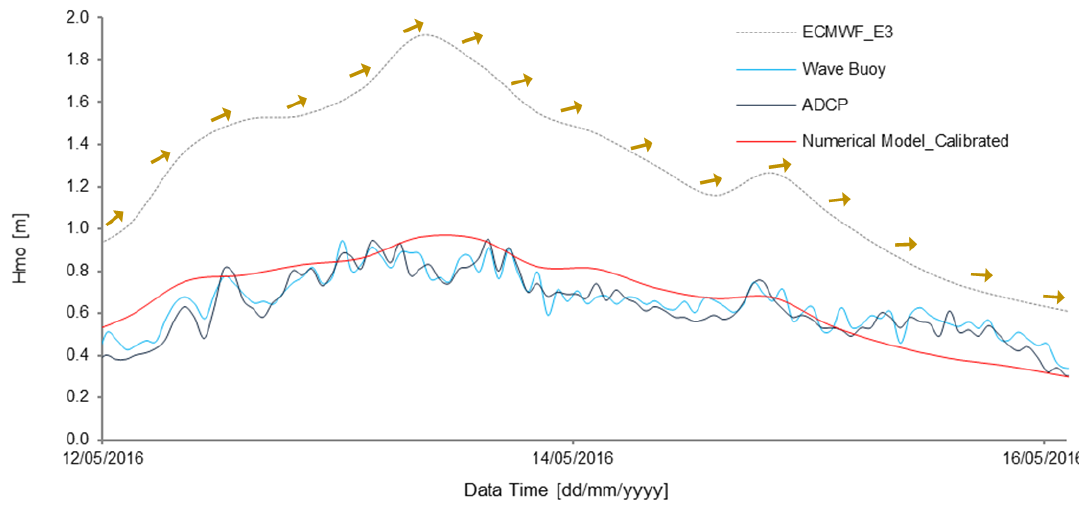
Figure 13. Observed and modeled time series of hourly averaged wave height. The observed time series of 6-hourly averaged wave height at the ECMWF grid point E3 (offshore of Gulf of Naples) is also reported.